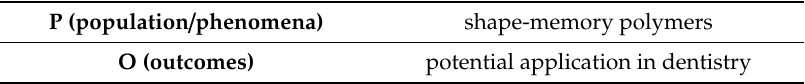
Table 1. Population / phenomena–outcomes (PO) framework for the research question.